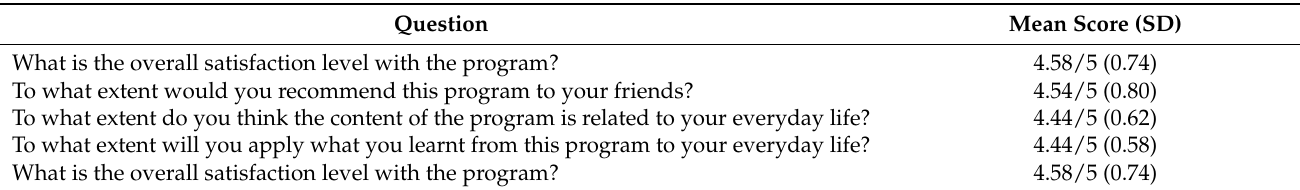
Table 4. Key results of the acceptability survey.